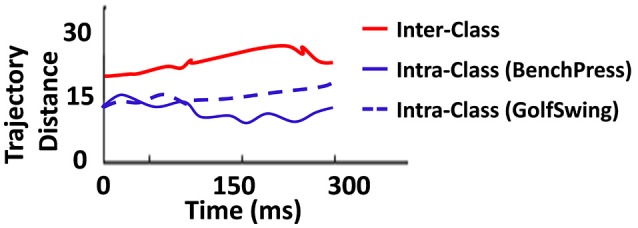
Euclidean distance between trajectories of same (and different) classes observed during testing for the 2-class problem(with 8 training example per class) of BenchPress/GolfSwing classification.